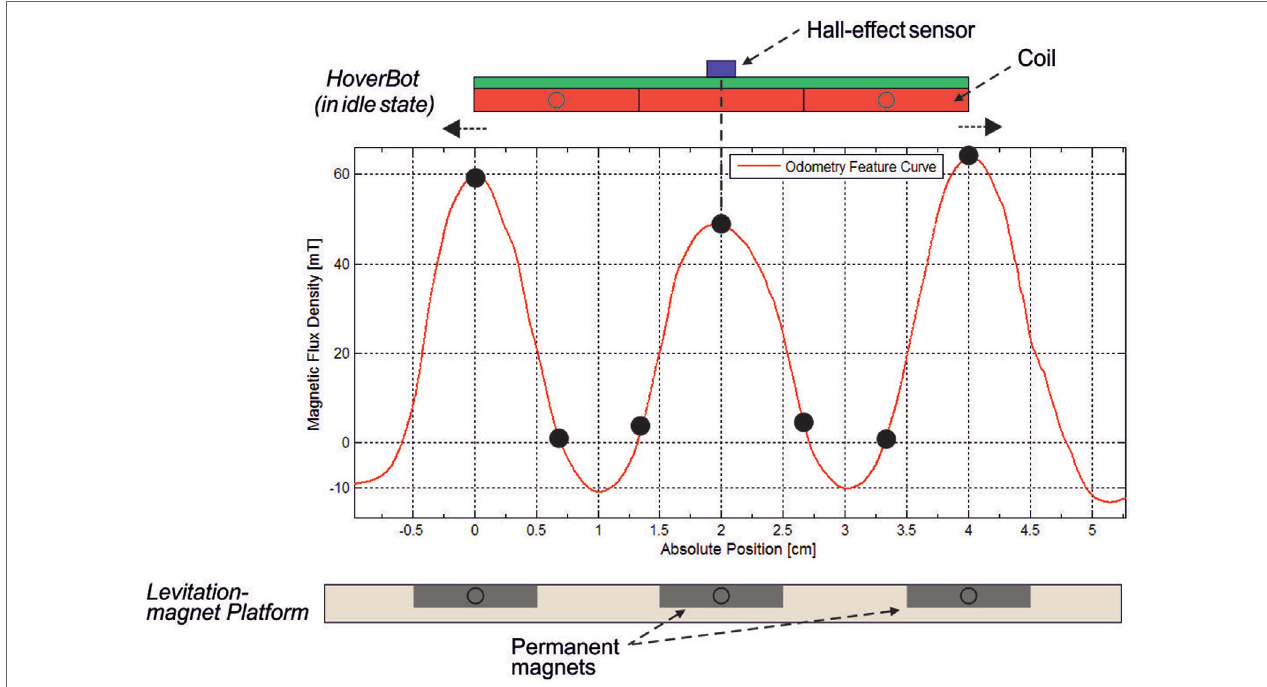
FigUre 4 | Experimental results showing that the magnetic flux density peaks correspond to the centers of the permanent magnets. The magnets are 2 cm displaced from one another. A HoverBot in idle state aligns with its Hall-effect sensor above a magnet. A step from one magnet to another causes the Hall-effect sensor to measure a peak-to-peak magnetic field curve. Specifically, a movement is decomposed into three individual steps in which the Hall-effect sensor measures a distinct magnetic flux density after each step, as indicated by a black